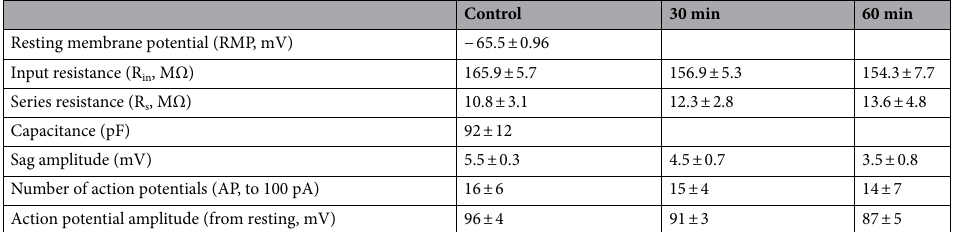
Table 2. Electrophysiological parameters measured during prolonged experiments. We measured different passive and active membrane parameters to determine that our recordings are feasible to be considered for further analysis. During voltage-clamp experiments, our R s values range between 7 and 17 MΩ and were thoroughly monitored along the experiment. In current-clamp experiments we checked R in , sag amplitude, number and amplitude of AP (n = 10 cells, 5